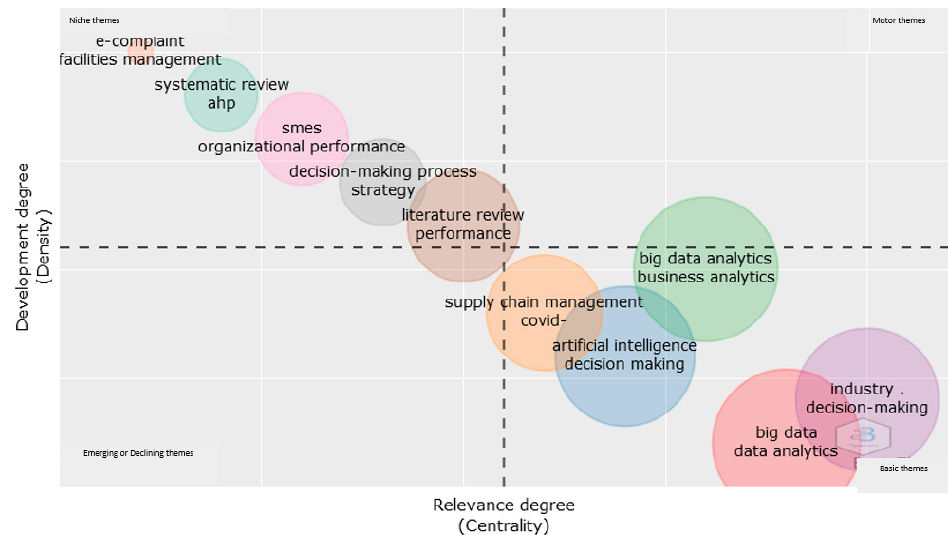
Figure 10. Thematic map based on authors’ keywords.